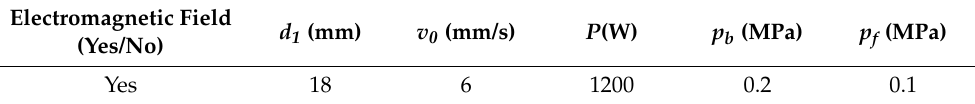
Figure 9. XRD atlas. Table 6. Process